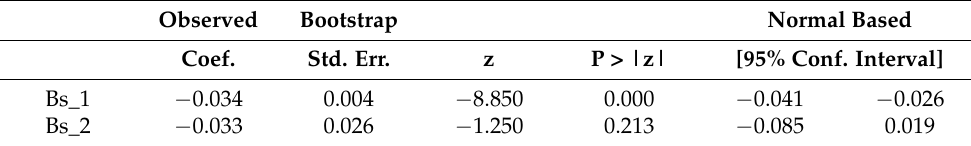
Table 5. Bootstrap test for the intermediation effect of bank